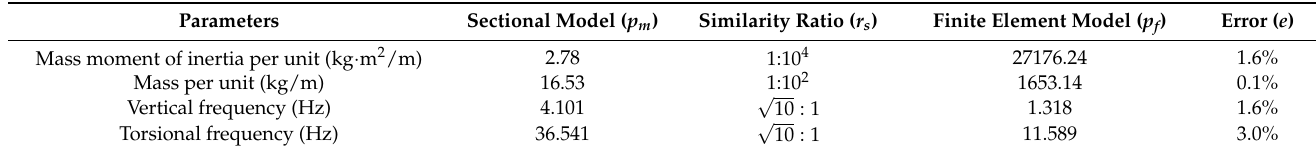
Table 2. Comparison of the parameters between the sectional model and the finite element model.